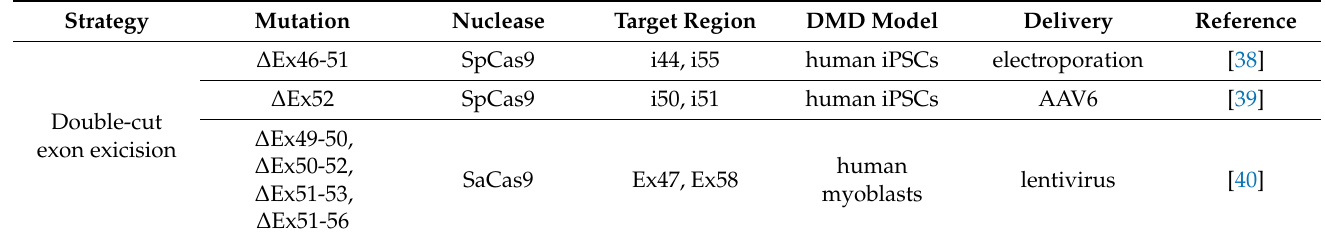
Table 2. CRISPR-mediated therapeutic strategies in human DMD